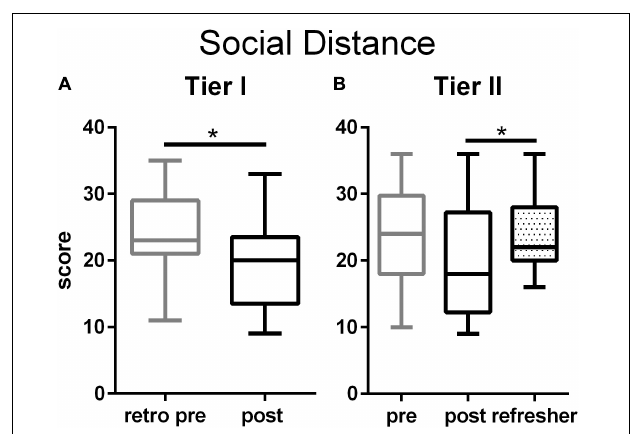
FIGURE 3 | Social distance scale among Tier I (A) and Tier II (B) teachers. Tier I teachers significantly reduced negative attitudes toward people with mental illness after the training ( p = 0.020, Cohen’s d = –0.70, two tailed t -test). Among the Tier II teachers, social distancing attitudes declined only as a trend after the training, but rose significantly at the time of the Refresher ( p = 0.031, η 2 = 0.049, one way ANOVA with Tukey’s multiple comparison post test). Boxes represent 25th to 75th percentiles with an internal bar at the median. Whiskers delineate maximum and minimum data points. Tier I N = 23 retrospective pre, 24 post, Tier II N = 44 pre, 40 post, 56 Refresher. For the post tests, *represents p < 0.05.